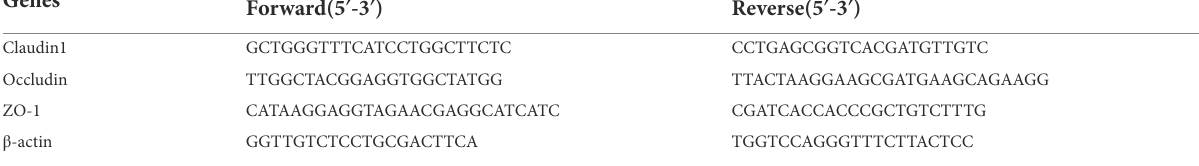
TABLE 1 Primer sequences for qPT- PCR.